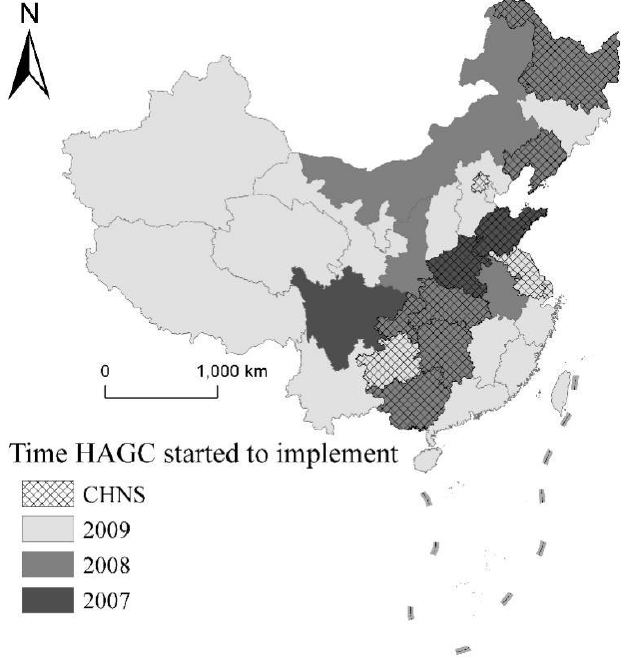
Figure 3. Implementation of the China HAGC by year across provinces and regions of CHNS.